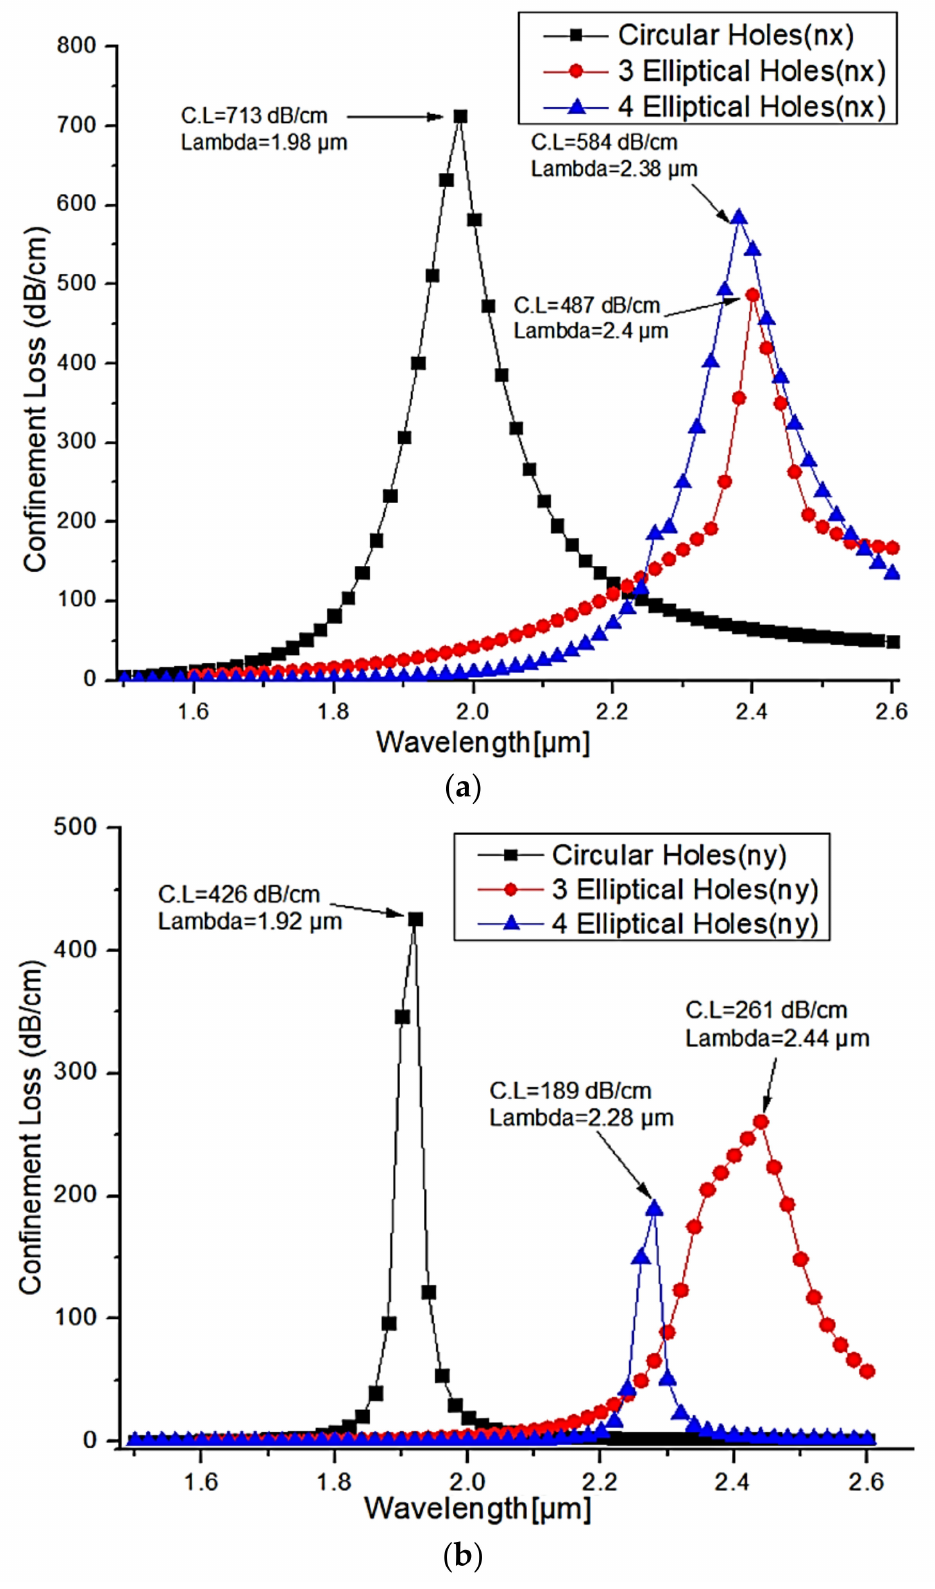
Figure 6. The confinement loss for the different shapes of air holes in ( a ) X-polarized mode ( b ) Y-polarized